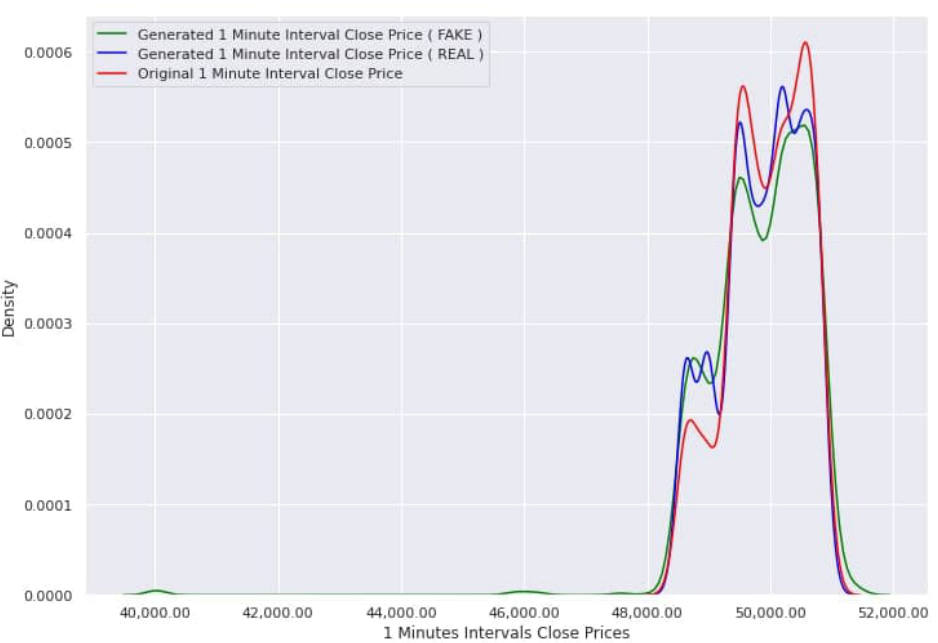
Figure 7. This graph shows the BTC one minute Interval Close prices and generated fake and real price data. BTC perpetual futures contracts are relatively volatile, with a relative large MAE of 72,840.8 compared with other perpetual contracts. The highest density from the original reaches 0.0006. The long tails from generated real and fake show the potential price volatility indicated by the original prices covering 40,000 to 48,000